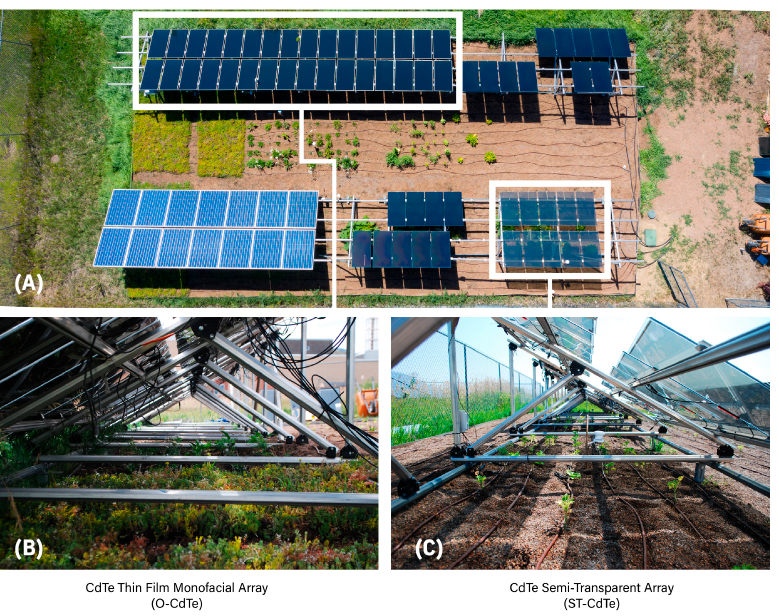
Figure 3. Foothills Campus site overview. ( A ) Construction emulates a RAPV installation. ( B ) Grow- ing environment under the O-CdTe panels at Foothills. ( C ) Growing environment under the 40% ST-CdTe solar panels at Foothills.